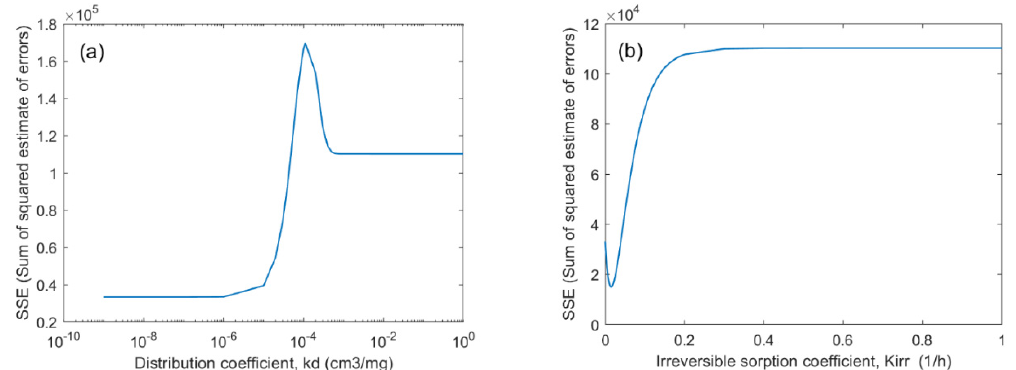
Figure 4. Goodness of fit in the simulations of toluene transport using ( a ) the linear isotherm model, ( b ) the kinetic-irreversible model. The curve shows the change in SSE (sum of squared error) according to the value of the adsorption parameter. Table 4. Sorption parameters estimated by fitting sorption models to the observed plume of toluene.